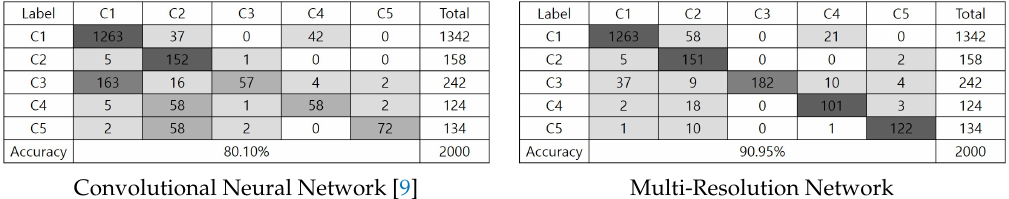
Figure 10. Multi-classification comparison.